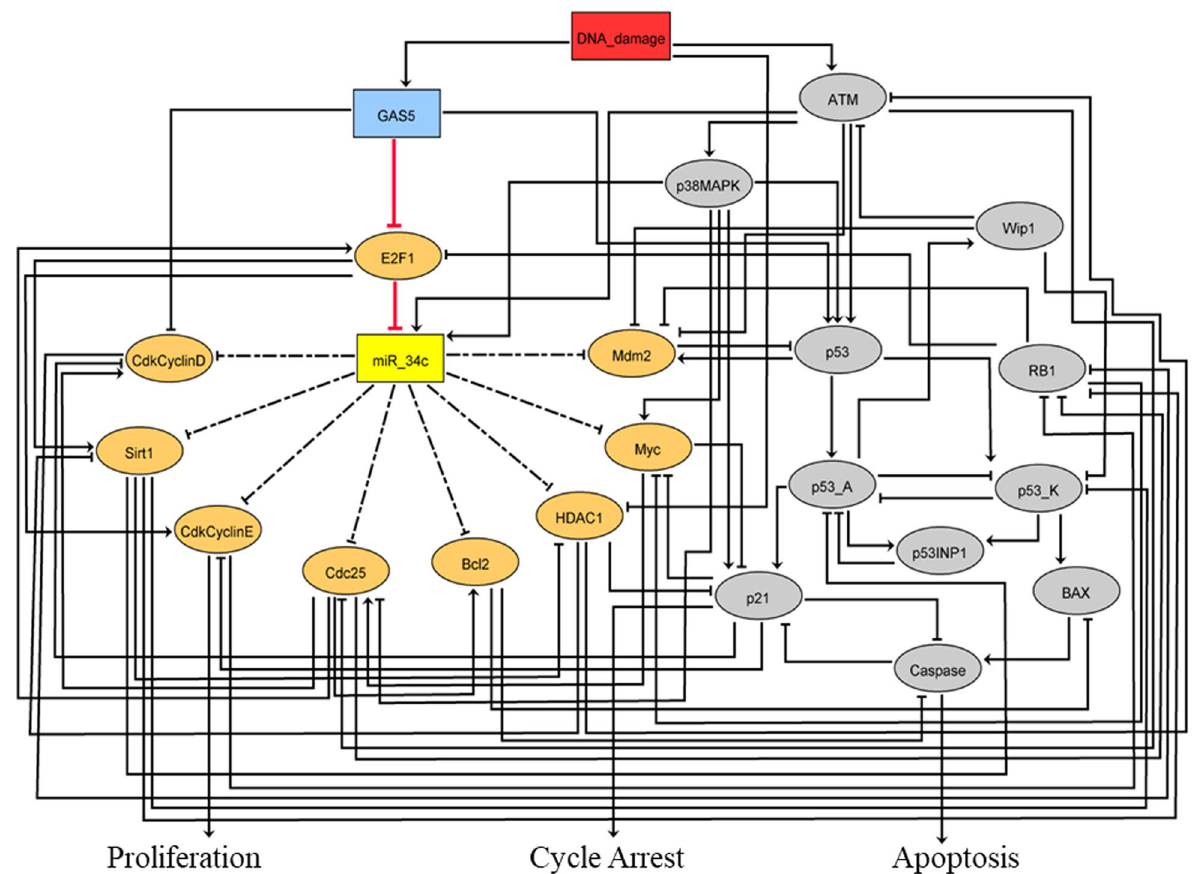
Figure 1. Gene regulatory network of lncRNA-GAS5 for the GC. Arrows indicate activations, and hammer- head arcs indicate inhibitions, respectively. The blue rectangular node represents lncRNA-GAS5, the yellow rectangular node represents miR-34c, and the red one represents DNA damage which is the input to the Boolean model. Dashed hammer-head arcs represent the targets of miR-34c highlighted by orange-colored oval nodes while other proteins are in grey-colored nodes. Model outputs are proliferation (in the lack of DNA damage) or cell cycle arrest, or apoptosis in the occupation of DNA